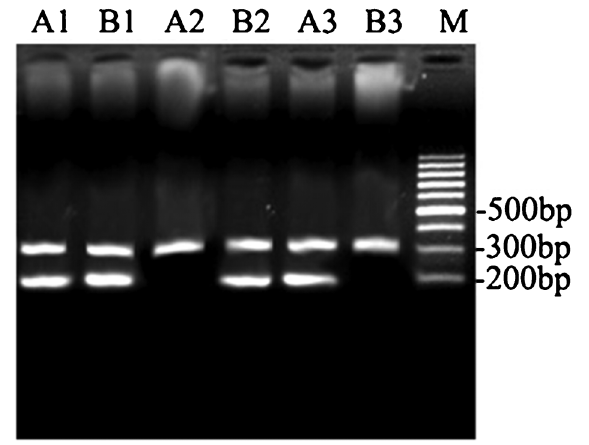
Figure 1. PCR amplification with specific primers for the identification of IL-18 promoter -607C/A (rs1946518) polymorph- isms in ischemic stroke patients and healthy controls. Samples 1, 2, and 3 were amplified with common downstream primers and internal reference upstream primers; samples A1, A2, and A3 were amplified with specific upstream primers (for the C allele); samples B1, B2, and B3 were amplified with specific upstream primers (for the A allele). The genotypes of samples 1, 2, and 3 were CA, AA, and CC, respectively. Lane M = DNA molecular weight